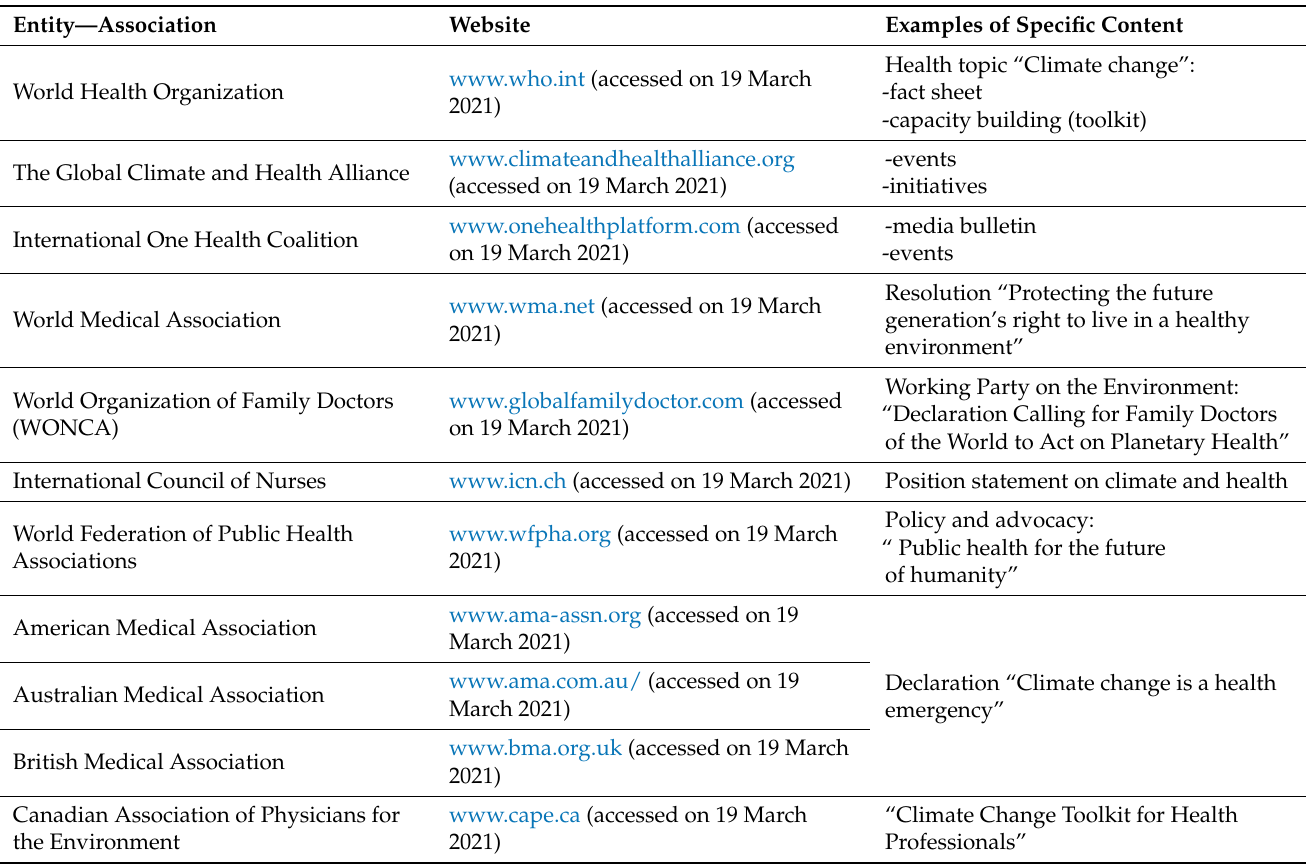
Table 3. Examples of websites of healthcare entities and associations calling for action on climate and environment change to protect